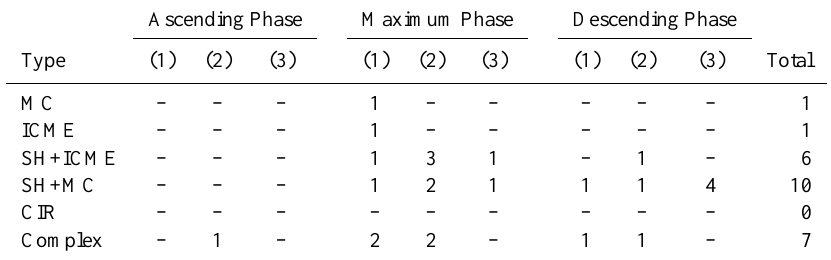
Table 3. Geoeffectiveness of the interplanetary phenomena on the main three phases of the SC 23. Each phase is further sub-divided, de- pending on the strength of the geomagnetic storm: (1) − 150nT ≥ Dst min > − 200nT; (2) − 200nT ≥ Dst min > − 300nT; (3) − 300nT ≥ Dst min > −